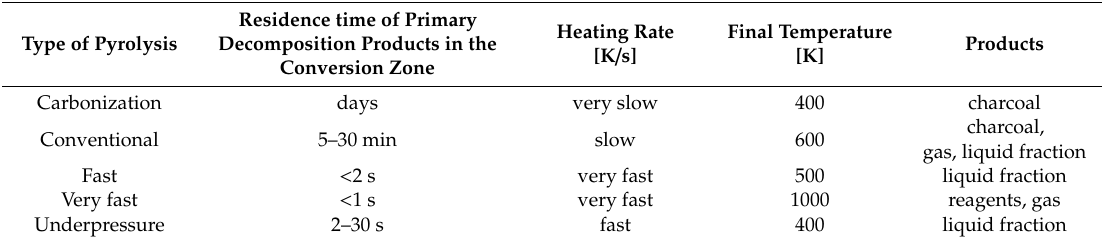
Table 1. Types of pyrolysis and characteristic parameters influencing the decomposition [13]. Residence time of Primary Type of Pyrolysis Decomposition Products in the Conversion Zone